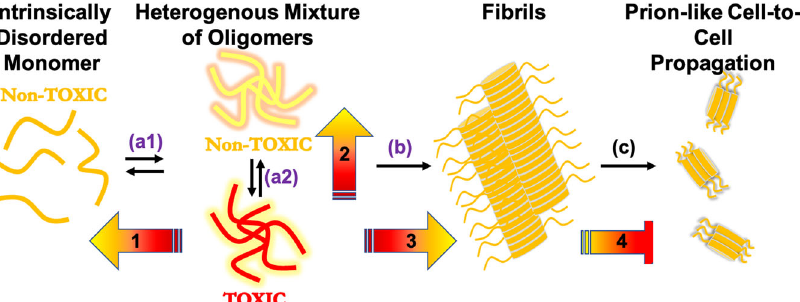
Fig. 12 Monitoring spontaneous α SN oligomers and conformation using live cell fl uorescence lifetime readouts. The intrinsically disordered α SN monomer is capable of misfolding into oligomers and fi brils, producing toxic assemblies that have been implicated in the pathology of disease. Oligomers comprise a heterogeneous mixture of metastable assemblies that have proven dif fi cult to monitor with high precision and accuracy, so most current strategies target the irreversible formation of large assemblies ( fi brils, arrow b ). However, disruption of fi brils can induce toxicity due to elevated levels of toxic oligomers. Our cellular FLT-FRET biosensors monitor reversible spontaneous oligomerization ( a1 ) in addition to structural remodeling within the oligomer assembly (e.g., conversion between toxic and non-toxic oligomers, a2 ), while also monitoring downstream processes such as fi brillization ( b ) and seeded aggregation ( c ) with high sensitivity. This study demonstrates the capacity of our drug discovery pipeline to identify compounds that modulate the toxicity of these α SN assemblies (gradient arrows 1 – 4), thereby shifting the equilibrium of these heterogeneous assemblies toward non-toxic